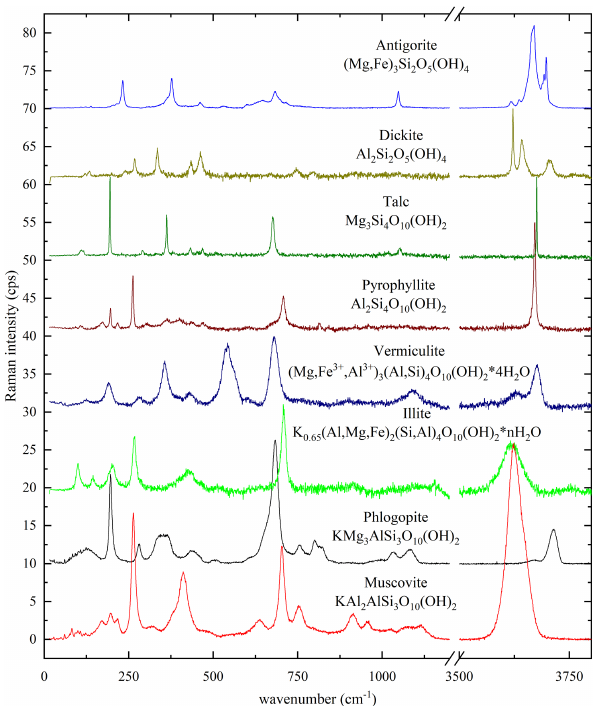
Figure 2. Raman spectra (in counts per second, cps) of various phyl- losilicates. The spectra are vertically offset for clarity.